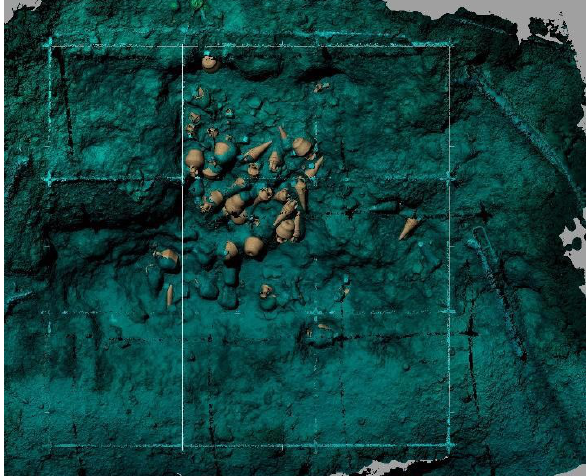
Figure 7. Comparing of the models obtained by the two different photogrammetric techniques.